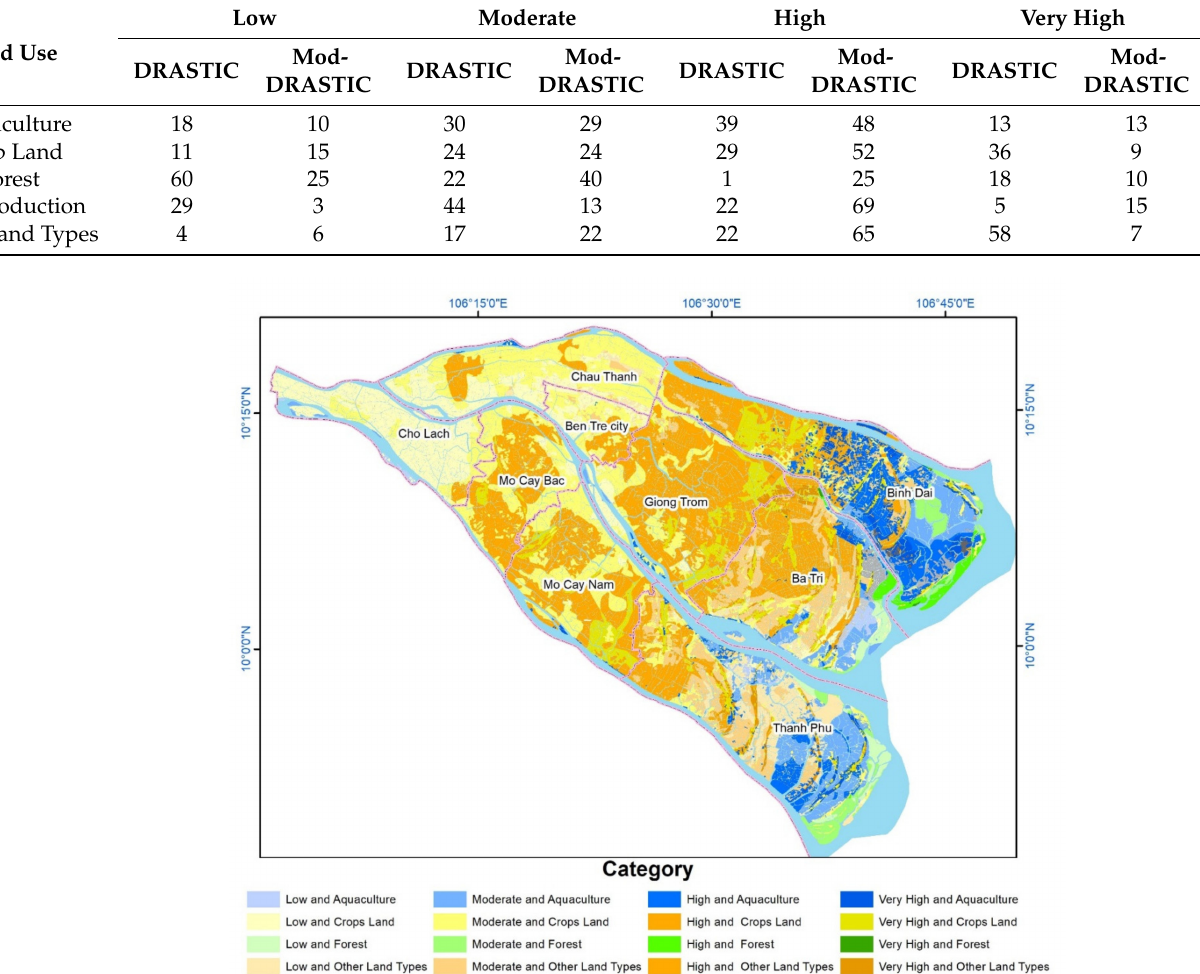
Table 7. The percentage of area at salinization risk by land use types in the study area (%).